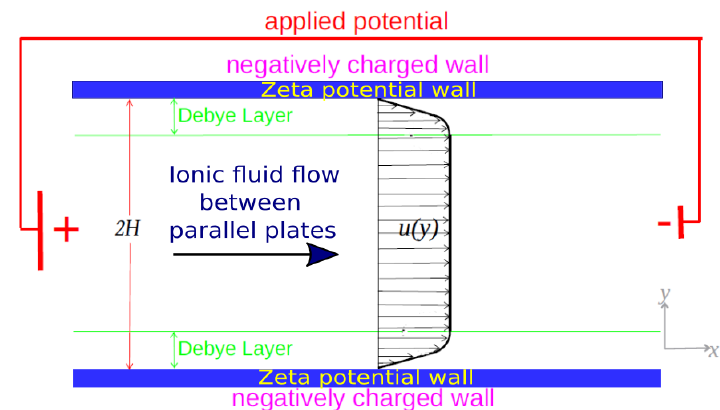
Figure 1. Scheme of electro-osmotic fluid flow in parallel plates. Velocity profile showed is fully developed for pure electro-osmotic fluid